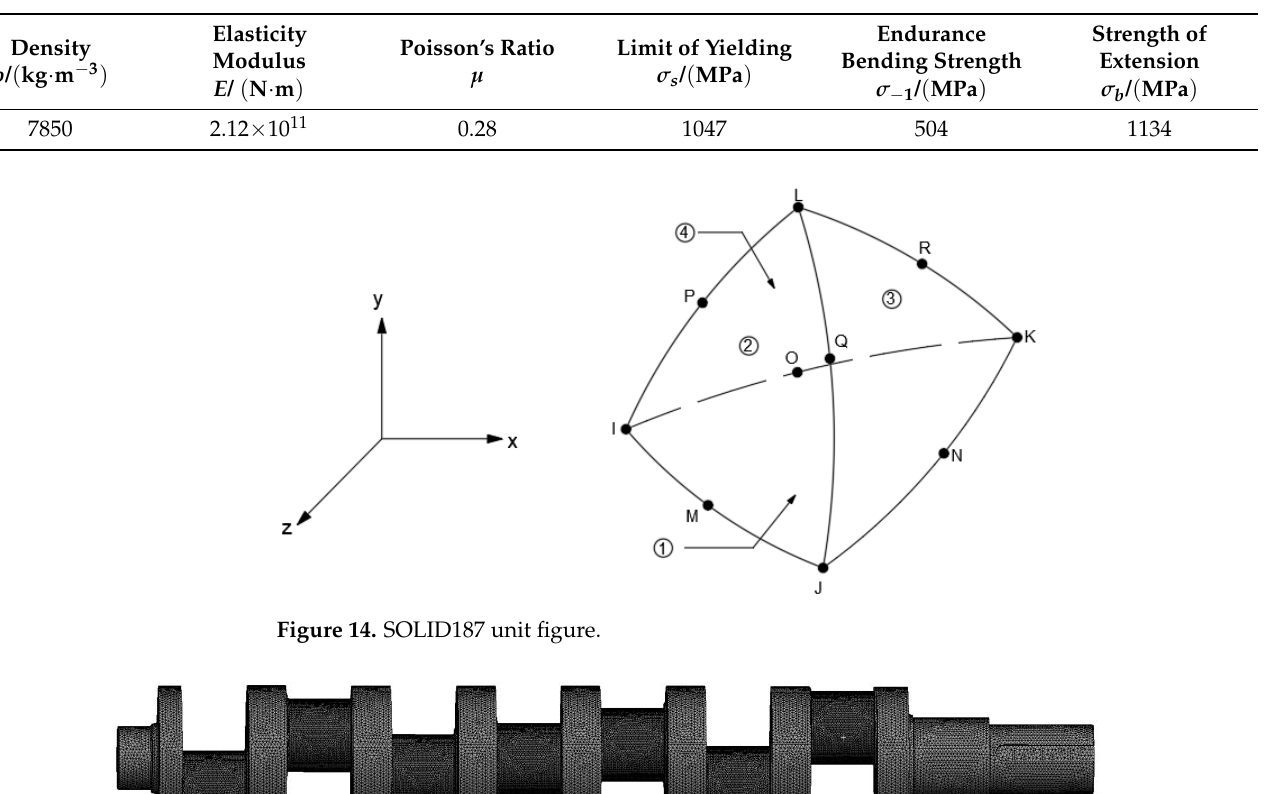
Table 2. Performance indicators of 42CrMo.